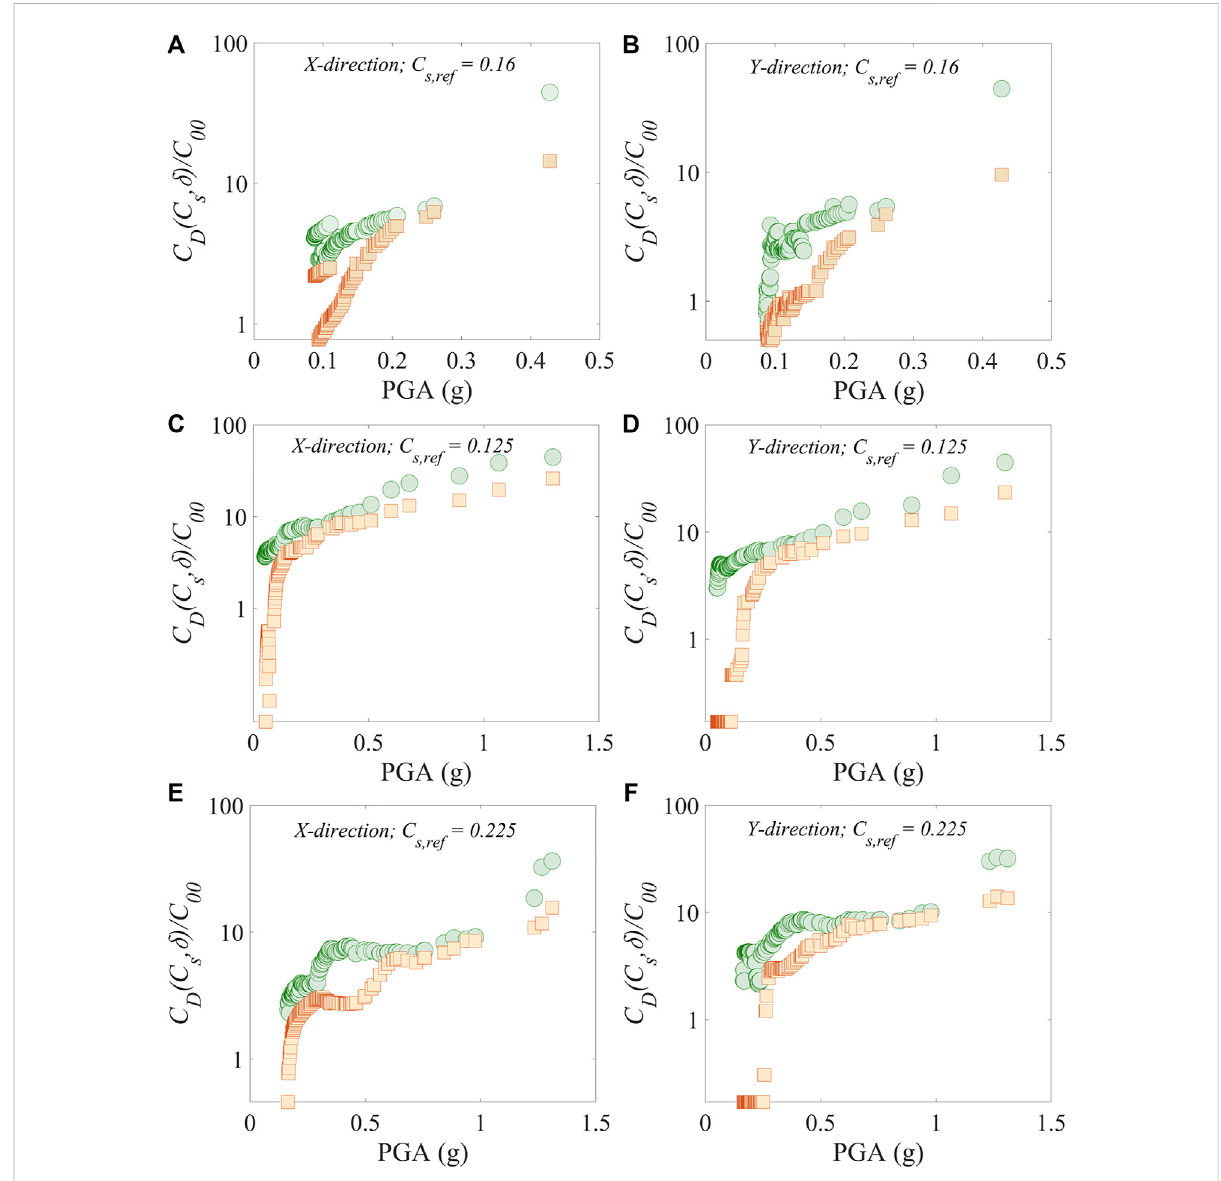
FIGURE 7 C D ( C s | δ ) for theRC buildings without and with NLVDs: (A) and (B) RC building located in Mexico City; (C) and (D) RC building located inPuebla, and (E) and (F) RC building located in the coast of Guerrero. Circles denote RC buildings without NLVDs and squares RC buildings with NLVDs.